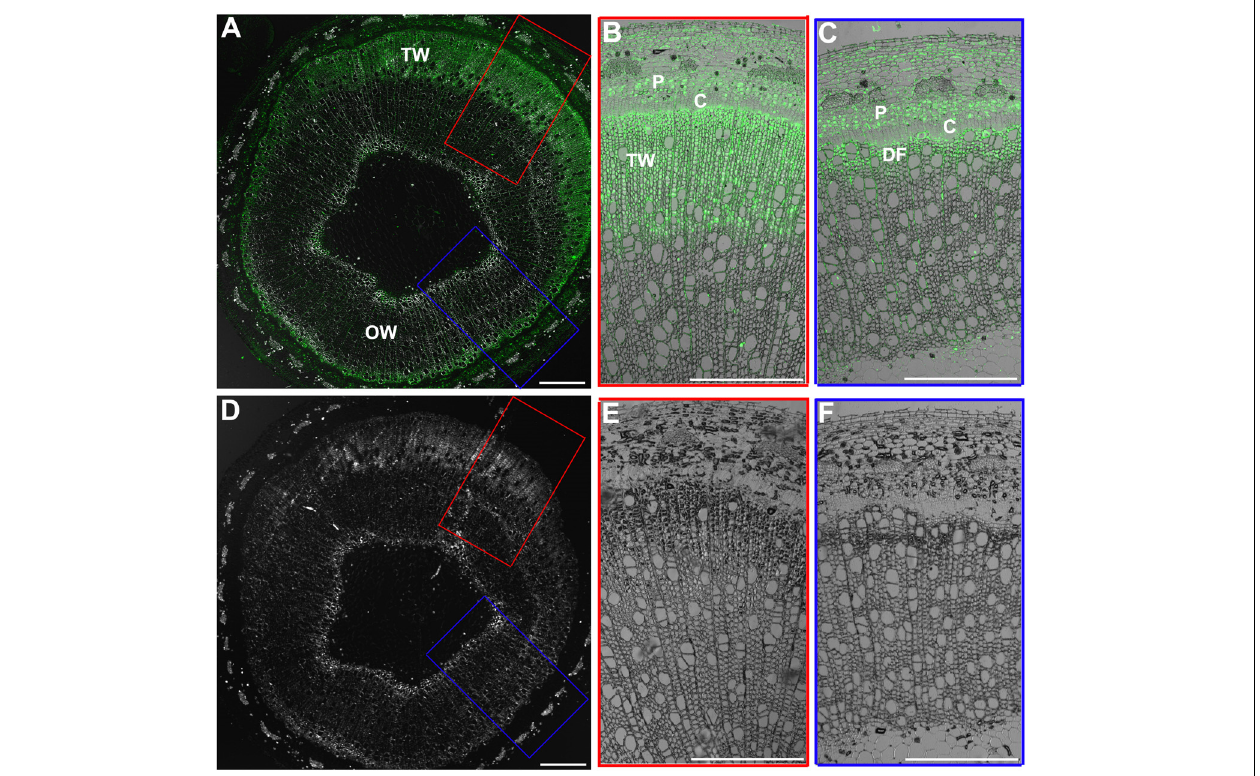
FIGURE 2 | Immunohistochemical analyses of BZR1 protein during TW formation. (A) Cross sections of the inclined stem of wild type Shanxin yang plants (WT) were hybridized with anti-OsBZR1 antibodies. The cross lines indicate the division between TW and OW. TW, tension wood; OW, opposite wood. Scale bar = 1 mm. (B,C) Higher magnification of the images in (A) . Bar = 0.5 mm. (D) Cross sections of the inclined stem was hybridized with PBS as control. Scale bar = 1 mm. (E,F) Higher magnification of the images in (D) . DF, differentiating fibers; DGF, differentiating G-layer fibers. Bar = 0.5